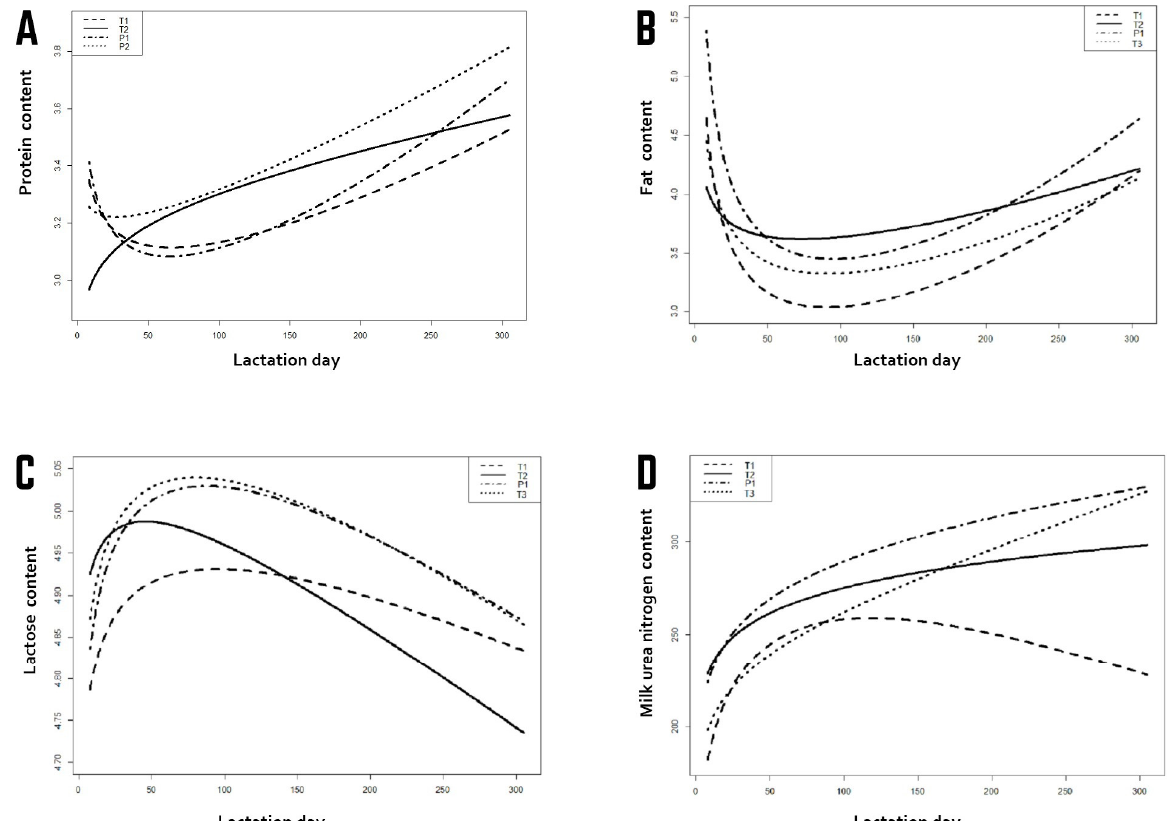
Figure 2. Presents the results for other milk traits in herds with different feeding management systems. Curves for protein ( A ), fat ( B ), lactose ( C ), milk urea ( D ) contents Herds: T1—one TMR (total mixed ration).throughout lactation; P1—one PMR (partial mixed ration) throughout lactation; T2 and T3—three feeding periods: FRESH, TMR I and TMR II, according to days in milk (kg).